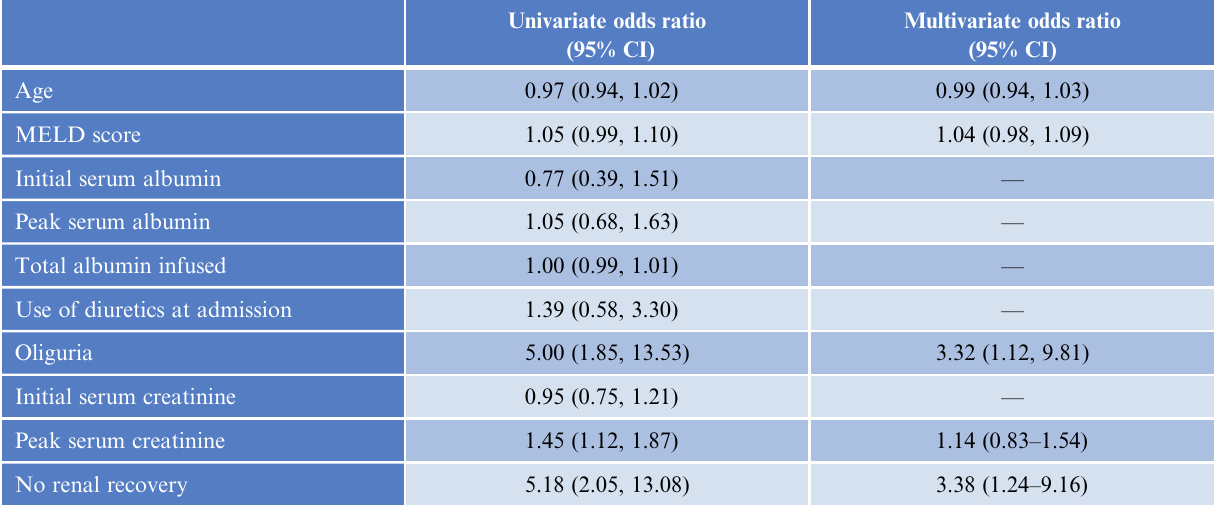
Table 3. Univariate and multivariable adjusted associations between clinical factors and pulmonary edema among adults with hepatorenal